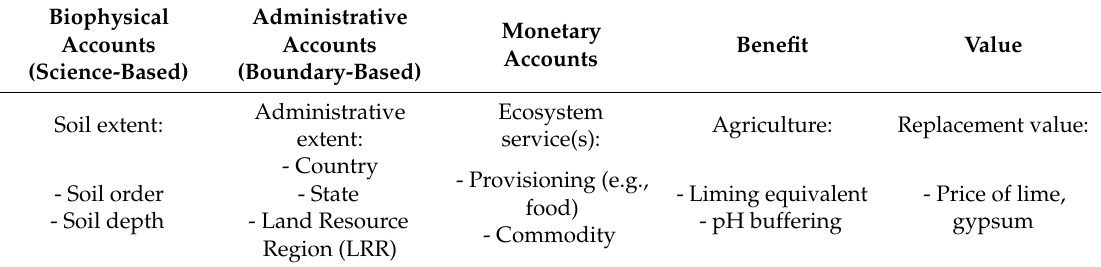
Table 1. Conceptual overview of the SIC accounting framework used in this